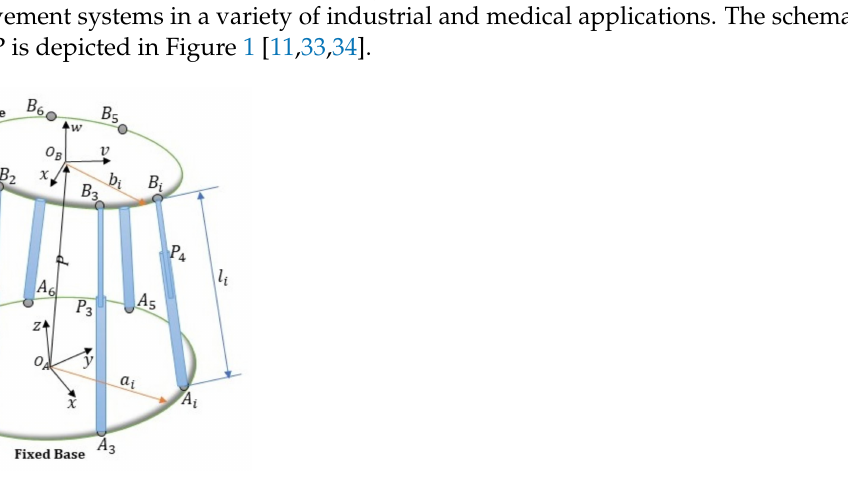
Figure 1. Schematic of a Stewart–Gough platform (figure adapted from Figure 2 in [35]).